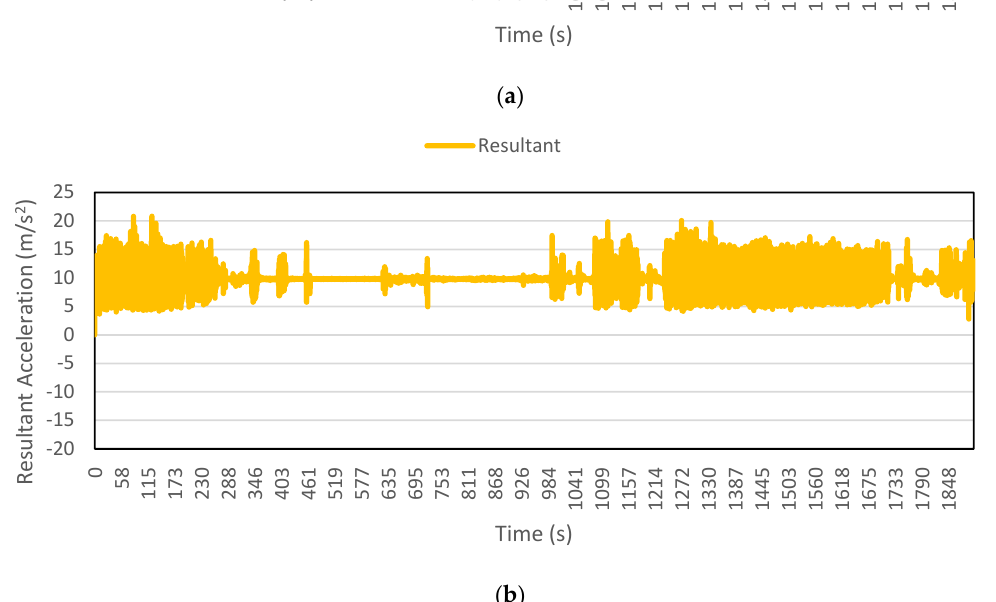
Figure 7. Accelerations recorded for a subway trip: ( a ) Accelerations along three axes; and ( b ) Resultant acceleration.